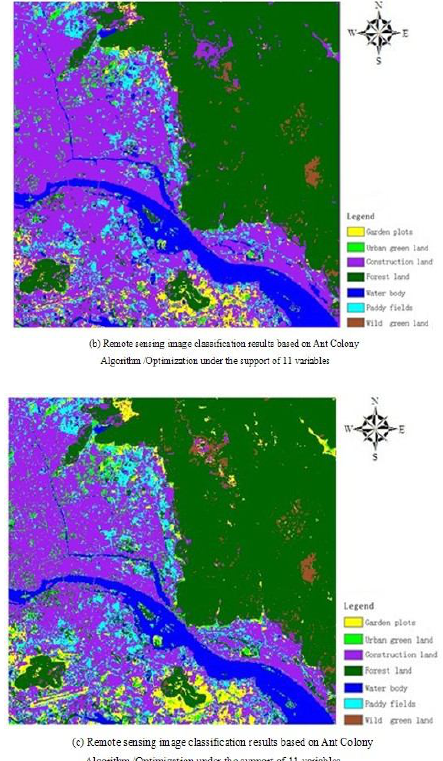
Figure 3. Classification based on ant colony algorithm under the support of different variables (a to c)